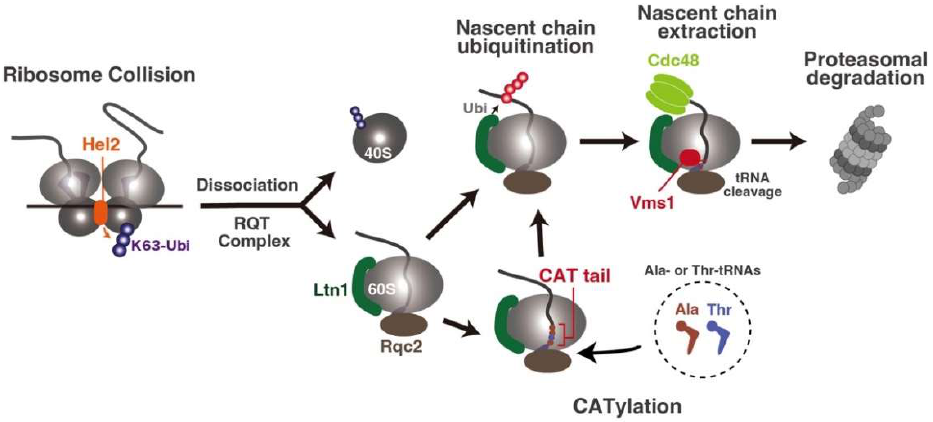
Figure 3. Degradation pathway of incomplete nascent chains. After the Hel2-mediated ribosome splitting, the incomplete nascent chain on the dissociated 60S subunit is recognized by Rqc2 and E3 ligase Ltn1 and is ubiquitinated. If Ltn1 cannot ubiquitinate the nascent chain, e.g., no lysine residue within the Ltn1-accessible region, Rqt2 recruits the alanine- (Ala-) or threonine- (Thr-) charged tRNAs to extend the C -terminal of the nascent chain (CATylation). It contributes to pushing out the lysine residue within the ribosome tunnel. After ubiquitination of the nascent chain, peptidyl-tRNA is cleaved by Vms1 at the cytosine-cytosine-adenine (CCA) end of tRNA; afterward, the nascent chain is extracted from the ribosome tunnel by Cdc48 and degraded by the